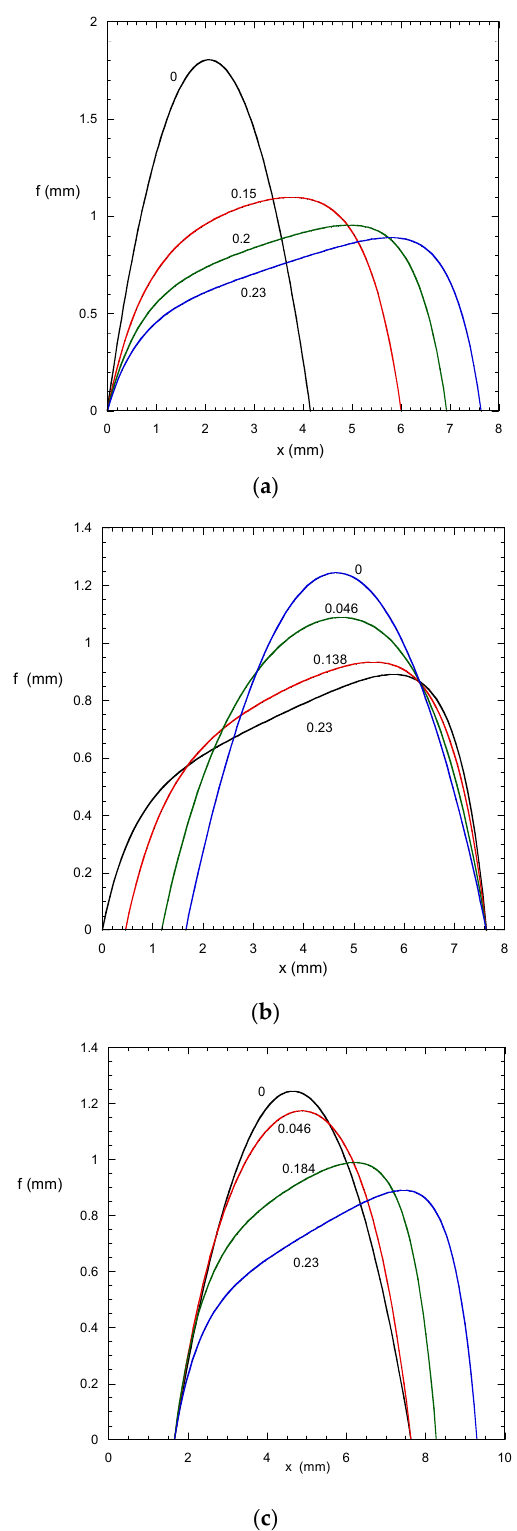
Figure 6. Evolution of droplet profile for periodic forcing and Bo N = 12 Bo T (V A = 5 mm 2 , θ a = 60°, θ r = 40°, θ ο = 60°) ( a ) starting transient ( b ) receding cycle ( c ) advancing cycle. The corresponding Bo T numbers are shown in the figures.